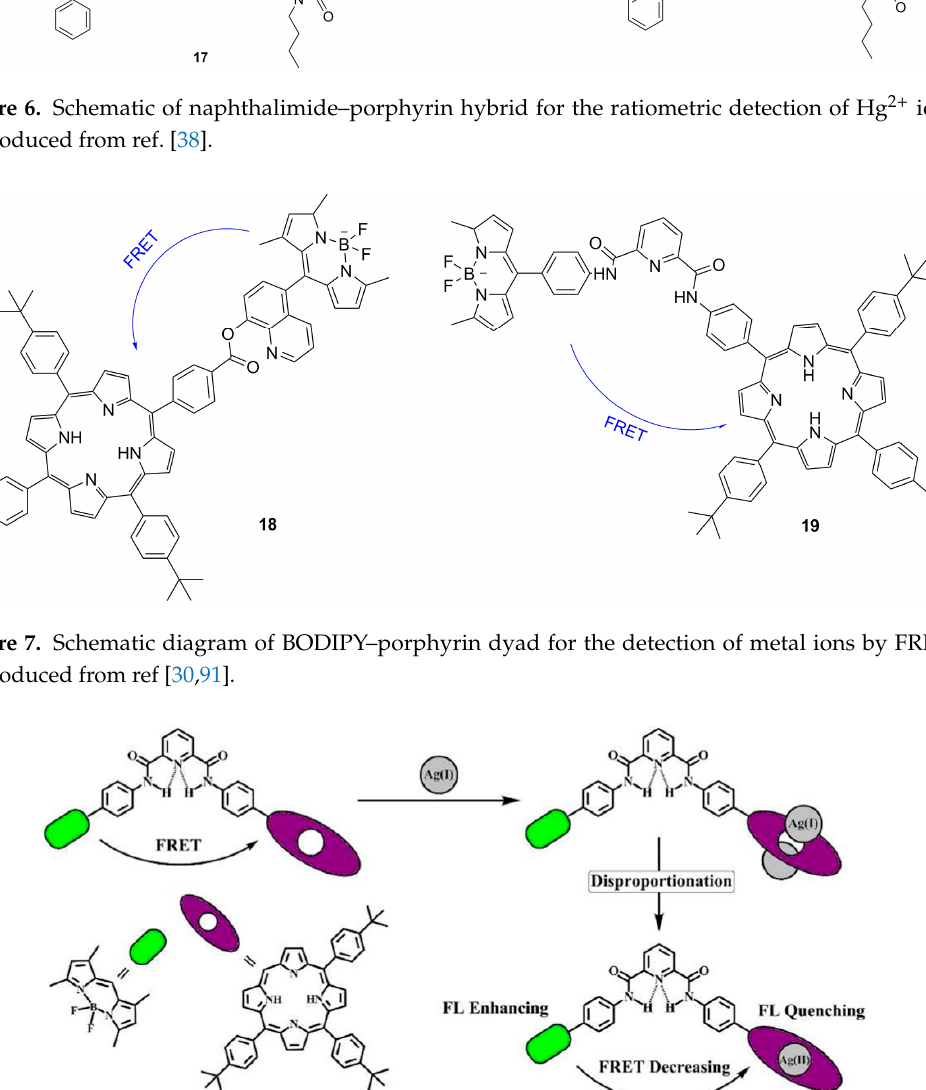
Figure 8. Sensing mechanism of the BODIPY–porphyrin dyad toward Ag + . Reprinted with permission from ref [30]. Copyright 2014 American Chemical Society.